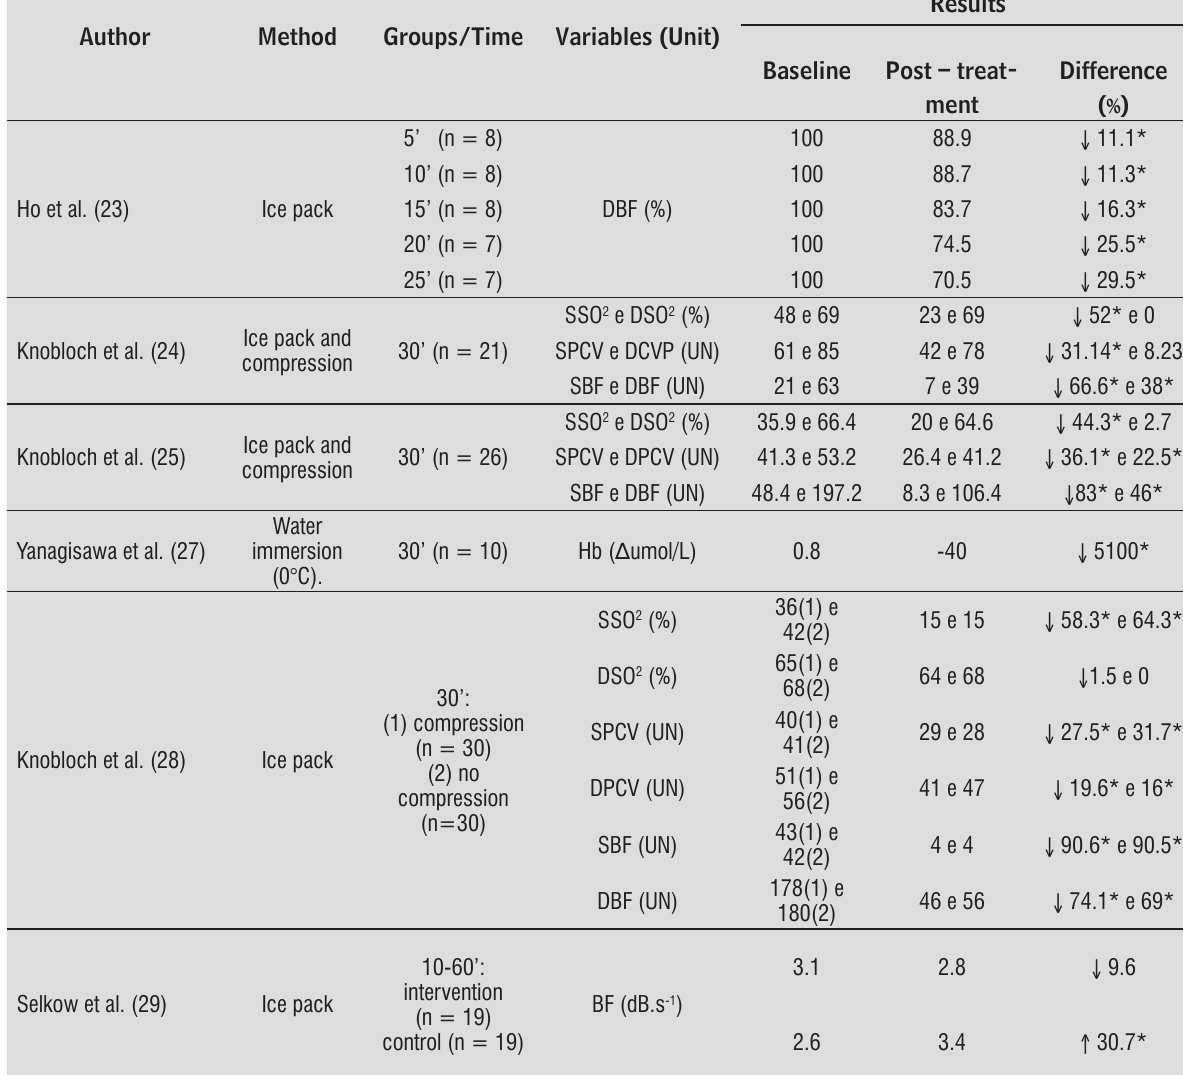
Table 2 - Effects of cryotherapy on circulatory and metabolic